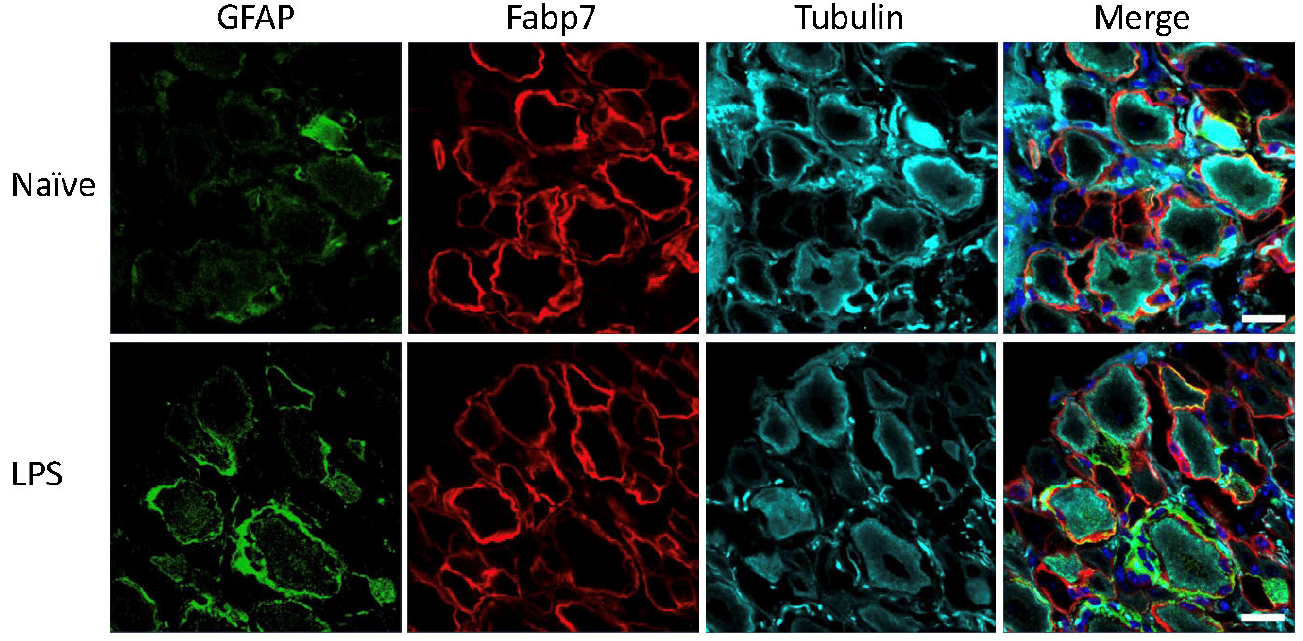
Figure 2. Mouse lumbar DRG following LPS treatment. GFAP (green), SGC marker Fabp7 (red), neuronal b-tubulin (magenta), and Hoechst nuclear marker (dark blue, merge only). Scale bar = 20 μ m.